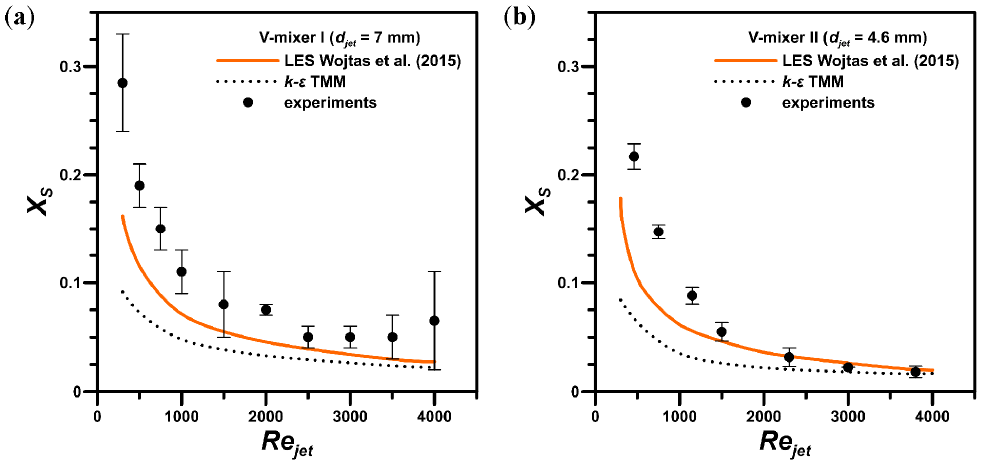
Figure 4. The effect of the jet Reynolds number on the final selectivity of the chemical reaction: ( a ) V-mixer I; ( b ) V-mixer II.